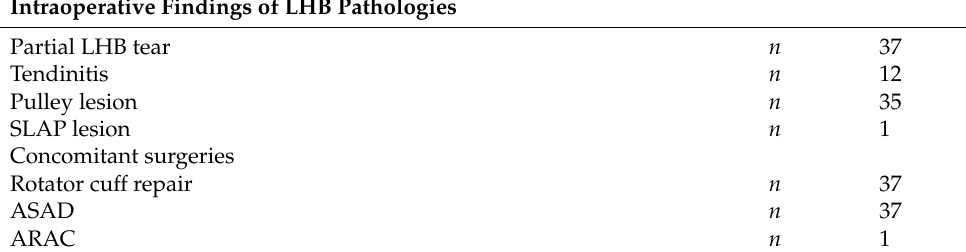
Table 2. Intraoperative findings of LHB pathologies and concomitant procedures of the study patients ( n =